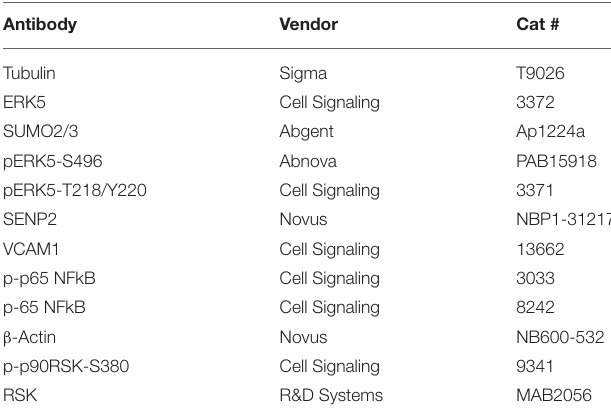
TABLE 1 | List of